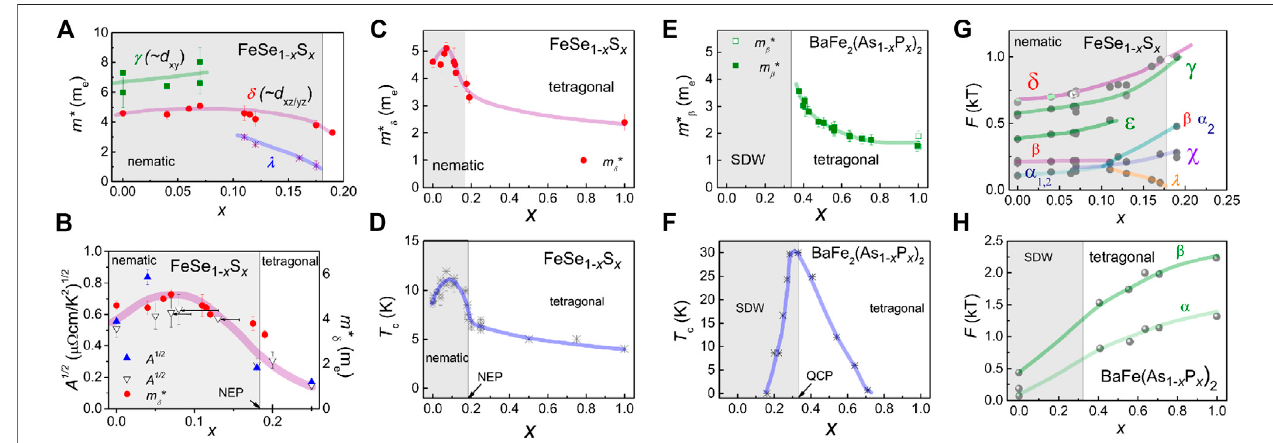
FIGURE 6 | Electronic correlations of FeSe 1 − x S x compared with BaFe 2 (As x P 1 − x ) 2 . (A) The quasiparticle effective masses of the high frequencies, γ and δ and the dominant low frequency, λ . Solid lines are guides to the eyes. Grey areas indicate either the nematic phase for FeSe 1 − x S x or the spin-density wave (SDW) for BaFe 2 (As x P 1 − x ) 2 . (B) ComparisonbetweentheFermiliquidcoef fi cient A andtheeffectivemassesfordifferentcompositionsofFeSe 1 − x S x .Thebandmassesofthe δ orbit (from Ref. 27) are compared to A 1/2 , extracted from the low temperatures Fermi-liquid behavior, and shown as solid triangles (after Ref. 28). Data shown as open triangleswerereported in Ref. 54using nominal x nom values and they are shifted in x tosmallervalues (as indicated by horizontal arrows) tomatchthe real concentration basedonthevaluesof T s ,asreportedpreviously[27,43].Thenematicendpoint(NEP)occurscloseto x ∼ 0.175(5)[27,43]andthesolidthicklinesareguidestotheeye. Thecomparison betweentheeffectivemassofmaximum orbitoftheouterhole(attheZpoint), δ ,inFeSe 1 − x S x in (C) and themaximum orbit β oftheouter electron band (at the A point) in tetragonal phase of BaFe 2 (As x P 1 − x ) 2 [56, 106] in (E) together with the evolution of the superconducting critical temperature, T c in (D) and (F) , respectively.Thequantum oscillationsdataforFeSarefromRef. 96.Aqualitative correlation isfoundbetweenthe T c andtheelectroniccorrelationsforthetwosystems, butsuperconductivity inthevicinityoftheSDWisafact3stronger thaninFeSe 1 − x S x .Superconductivity isenhancedatthemagneticcriticalpointinBaFe2(As x P 1 − x ) 2 but this does not occur at the nematic end point in FeSe 1 − x S x , suggesting that the nematic fl uctuations are not the main driver for superconductivity. Instead, a local peak in T c inside the nematic phase may signify an enhanced low-energy spin fl uctuation in this regime [44]. The evolution of the multiple observed quantum oscillations